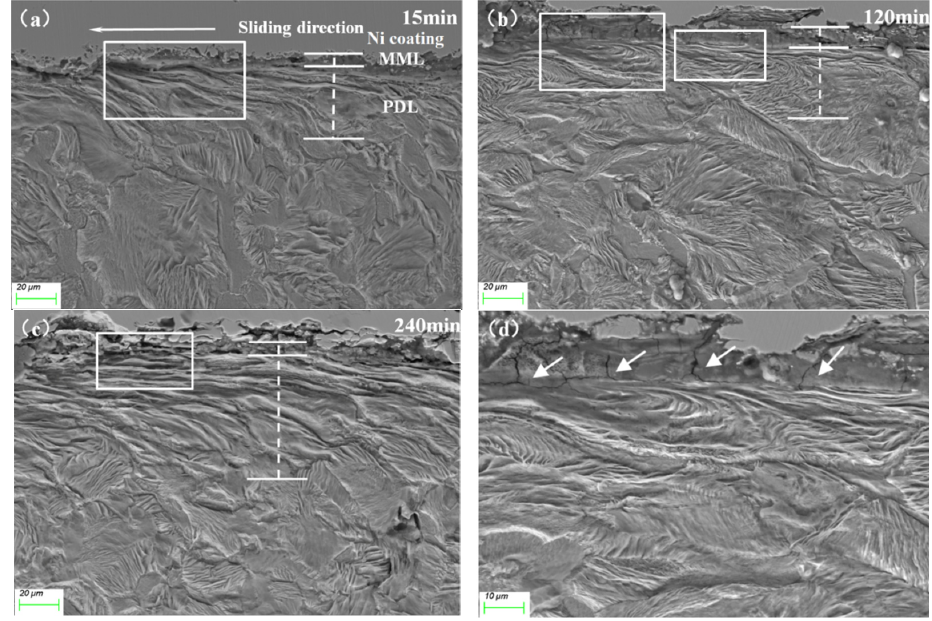
Figure 6. Cross-sectional microstructures of 40Cr pins after rotary sliding: ( a ) 15 min, ( b ) 120 min, ( c ) 240 min, ( d ) the magnified region in ( b ).